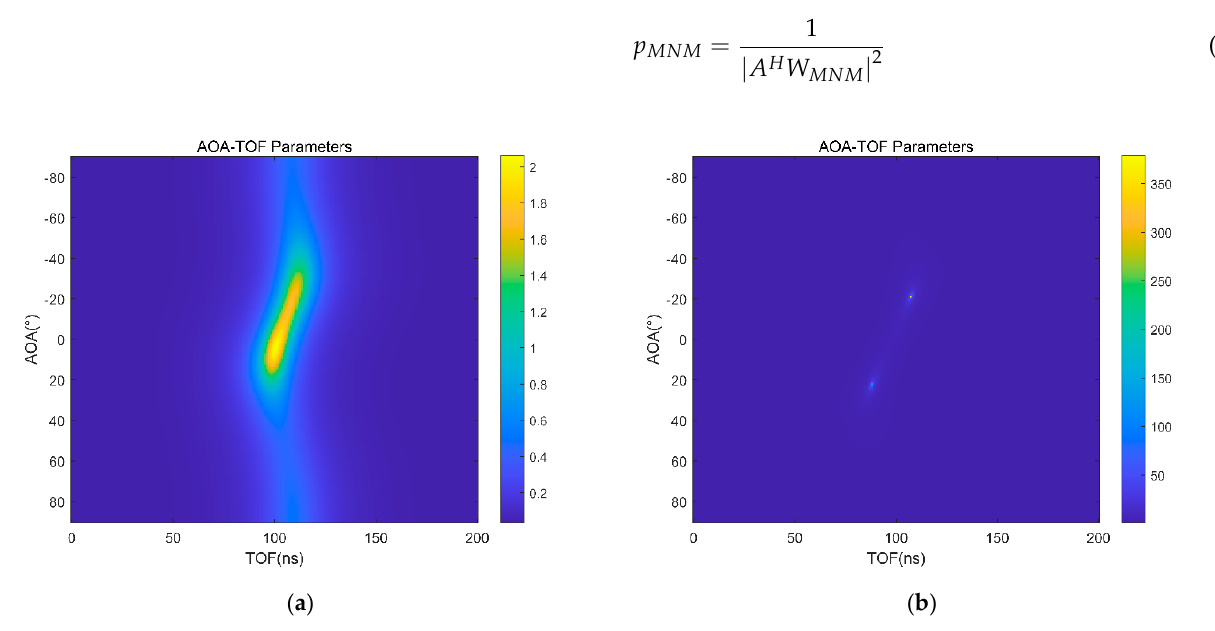
Figure 4. ( a ) AOA and TOF are estimated by MUSIC algorithm; ( b ) AOA and TOF are estimated by MNM algorithm.